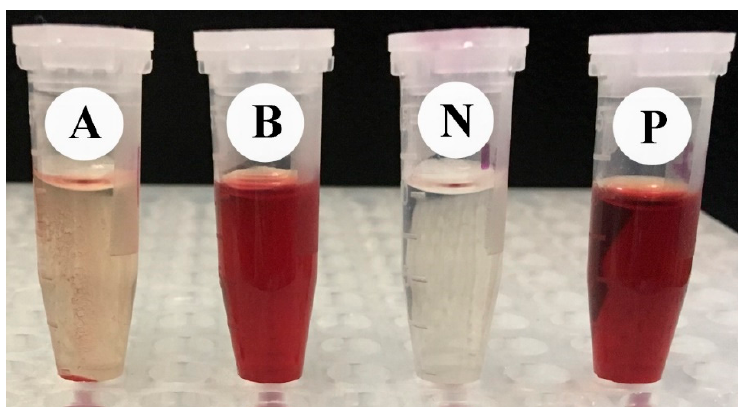
Figure 12. The hemolytic effect of ( A ) Ricinus communis ethanol leaf extract (RcExt) and ( B ) extract with gold nanoparticles (RcExt-AuNPs) on RBCs. ( P ) and ( N ) are the positive and negative controls, respectively.